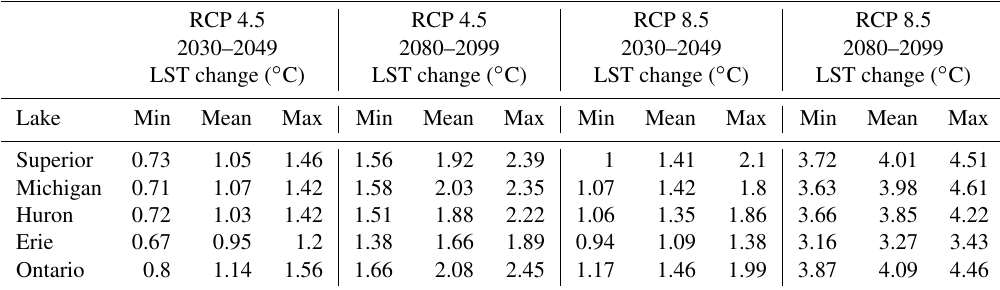
Table 5. GLARM-EA3 projected changes in annual mean LST in the five Great Lakes in the mid-century (2030–2049) and late century (2080–2099) for the RCP 4.5 and RCP 8.5 scenarios, relative to the present-day climate (2000–2019). The maxima (Max) and minima (Min) indicate the range of the three individual GLARM